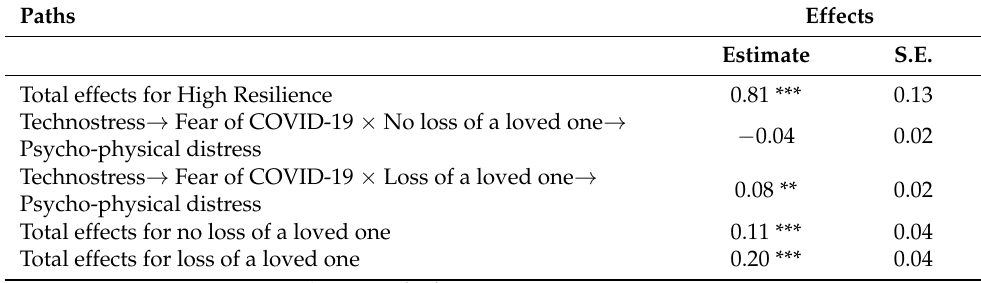
Figure 2. Path coefficients of the hypothesized model . ** p < 0.01; *** p < 0.001.